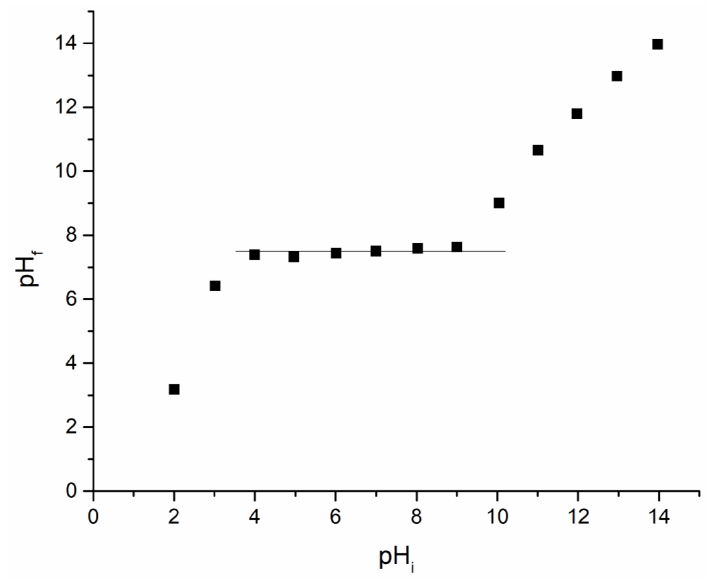
Figure 4. Point of zero charge, pH pZc .